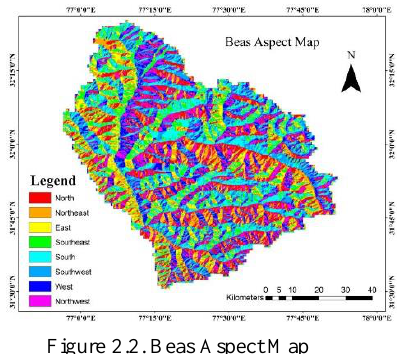
Figure 2.2. Beas Aspect